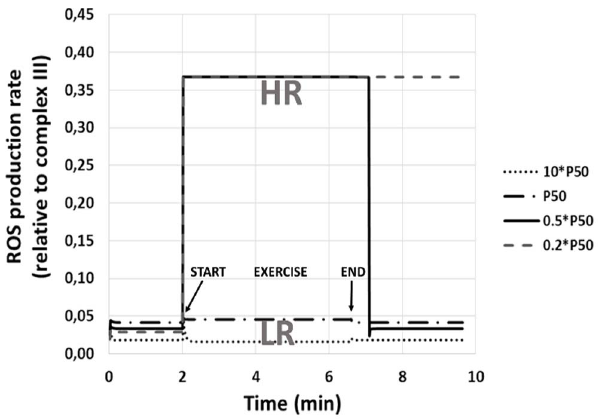
Figure 1. Dynamics of ROS production (expressed as SQo produced, normalized to total complex III abundance (taken as 0.4 nmol/mg mitochondrial protein)) at four steady state concentrations of oxygen (expressed as mitochondrial Po 2 relative to P 50 , the oxygen partial pressure at the half-maximal rate of respiration). Before and after exercise, rest is simulated (no ATP hydrolysis, proton gradient dissipates only due to membrane leak). Between 2 and 6.6 min, exercise is simulated (membrane proton gradient dissipates due to ATP hydrolysis and ATP synthase activity). Overall, ROS production falls into two distinct patterns: one (HR, seen when Pm O = P 50 v 0 : 67 ) reflects high ROS generation and the other (LR, 2 when Pm O = P 50 § 0 : 67 ) reflects little or no ROS generation compared 2 to rest. Note post-exercise persistence of high ROS generation, to P 50 ratio. especially at the lowest Pm O 2